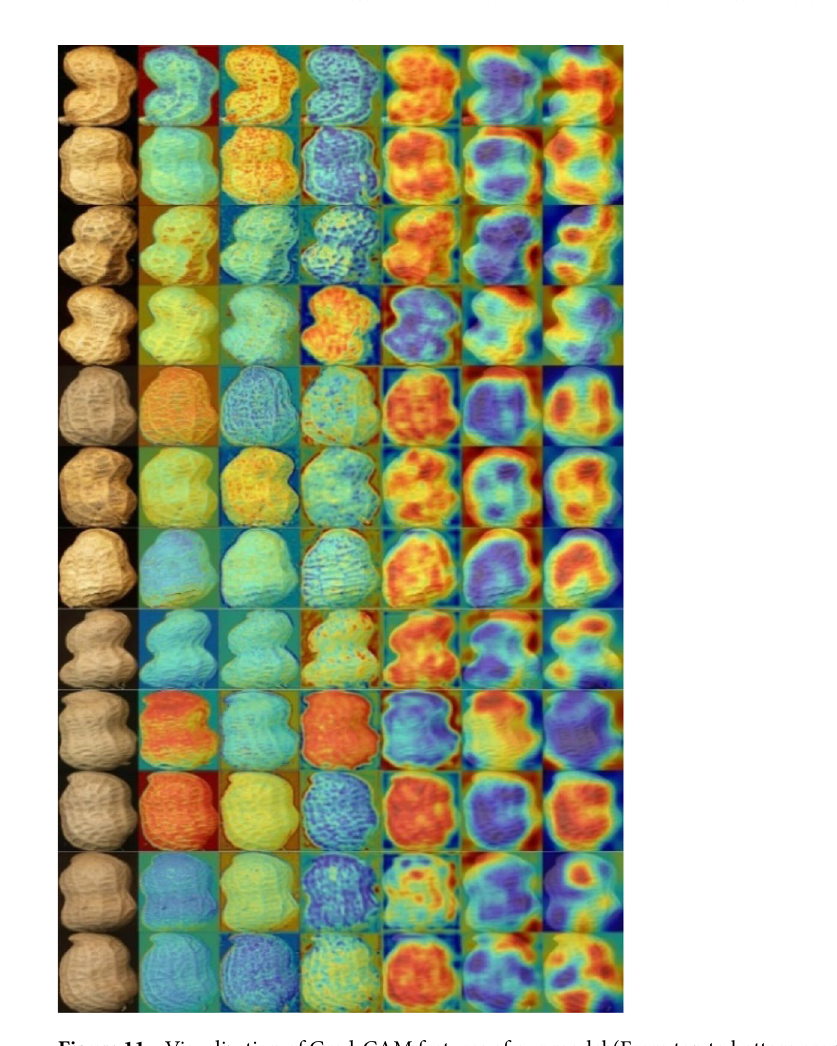
Figure 11. Visualization of Grad-CAM features of our model (From top to bottom are peanut samples of 12 varieties and from left to right are peanut samples and characteristic map of